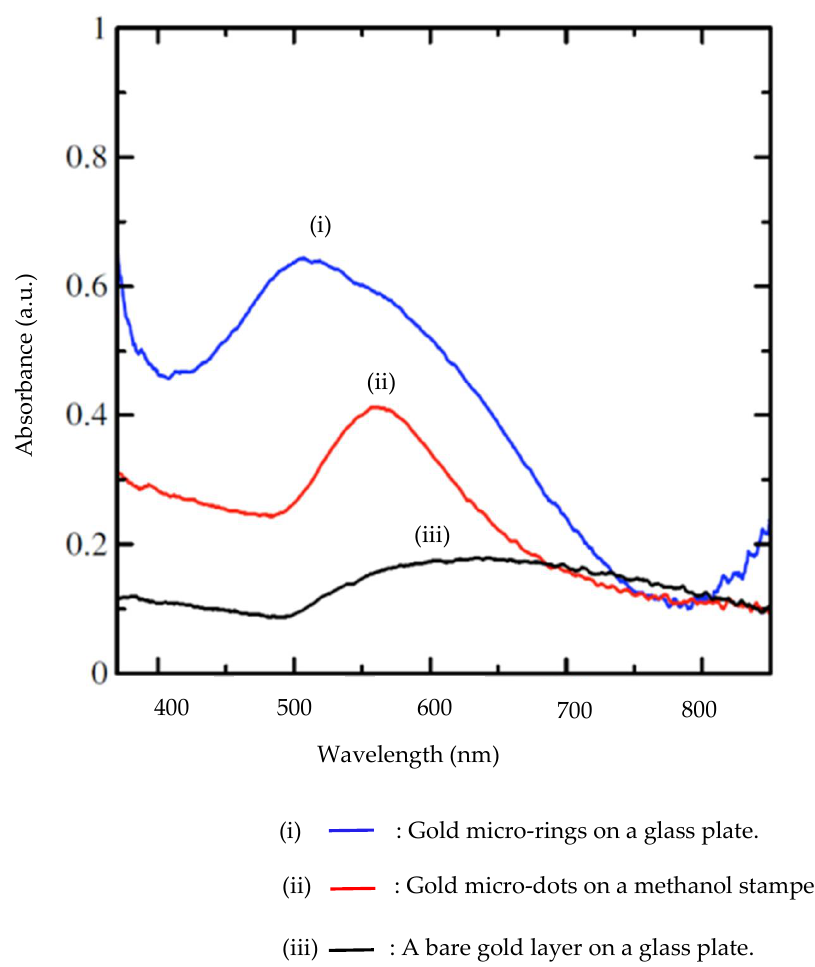
Figure 5. The spectral absorbance of (i) the gold micro-rings on a glass plate and (ii) the gold microdots on a methanol stamped glass plate, and (iii) a bare gold layer on a glass plate.